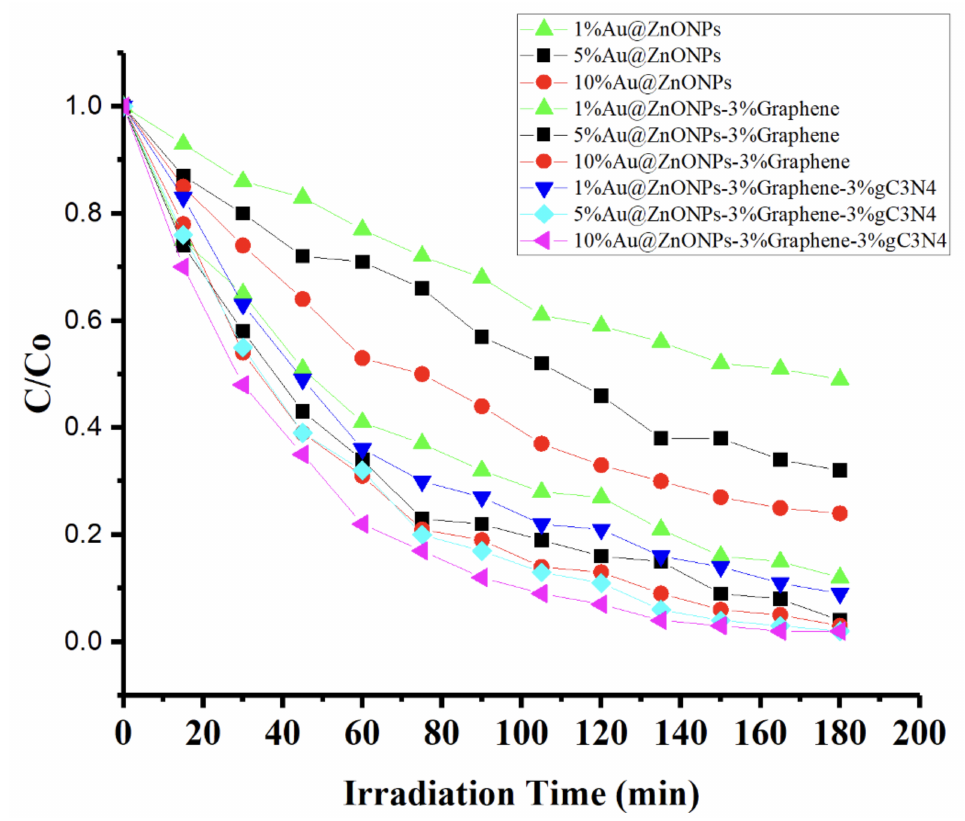
Figure 8. Photodegradation rate of LFX as a function of time, using the different catalysts